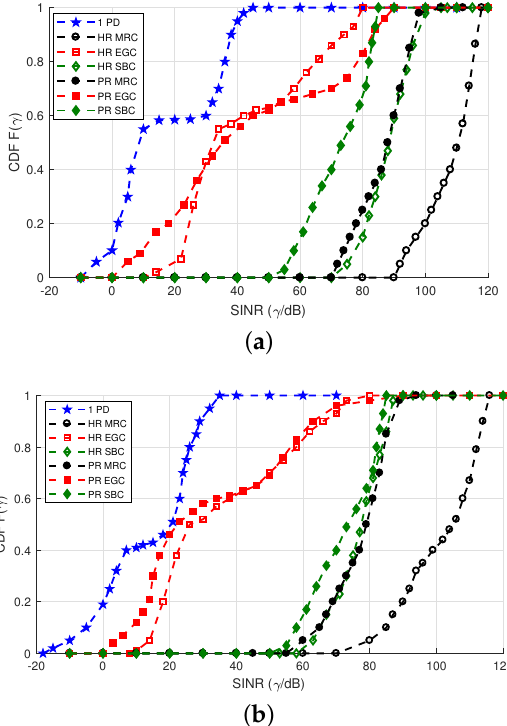
Figure 14. CDF of the SINR for the single PD, hemi-dodecahedron, and pyramidal ADRs, with their signal combining schemes, in the underground mining VLC scenarios. CDF of the SINR curves for the ( a ) mining roadway and ( b ) mine working face